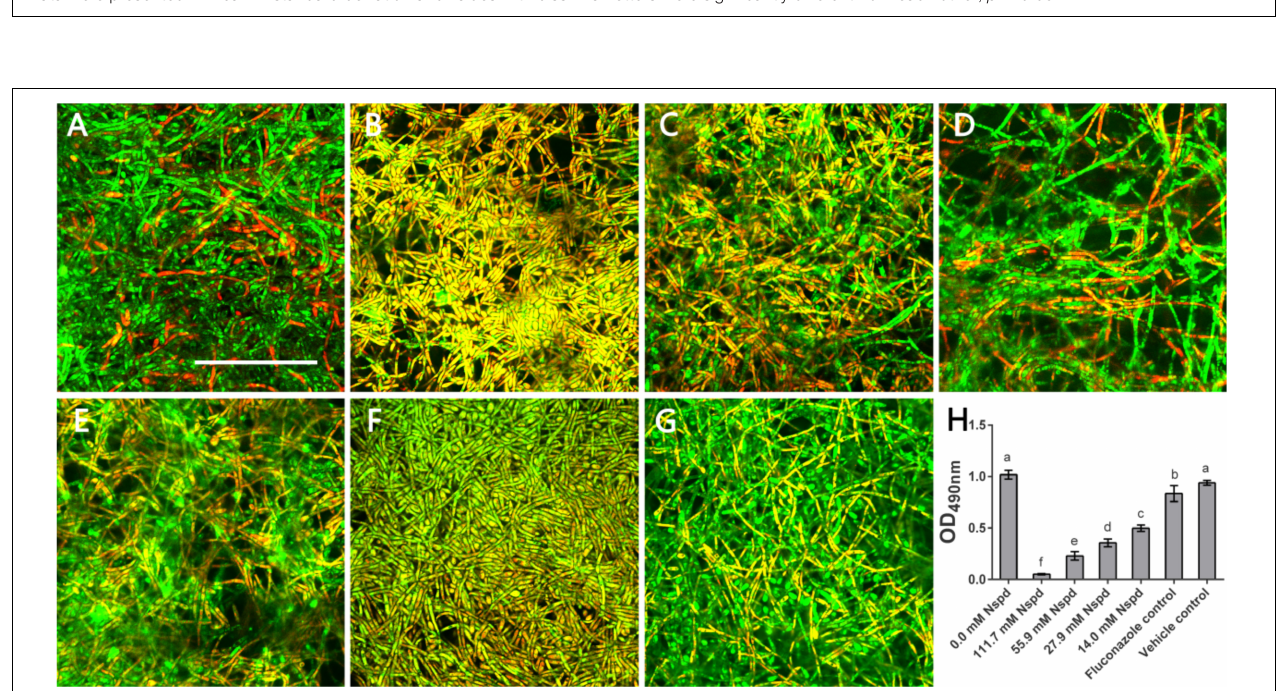
FIGURE 2 | Live/Dead staining and metabolic activity of C. albicans biofilms. Representative C. albicans biofilm images revealed by live/dead staining: (A) Blank control group (0 mM Nspd) showed few dead cells in a mature biofilm. (B–E) The number of dead cells (red) decreased as Nspd was diluted from 111.7 to 14.0 mM. (F) 80 µ M fluconazole group and (G) vehicle group (0.08% ethanol), both displayed a few dead cells inside the biofilm. Live cells appeared as green and dead cells appeared as red; yellow/orange colors were the result of an overlap of fluorescent dyes; bar = 50 µ m. (H) Metabolic activity of C. albicans biofilms was determined by XTT assay. A clear dosage effect relation was displayed in the metabolic level and dilution of Nspd. Nspd could significantly suppressed the metabolic activity of fungal cells in mature biofilm, much more effective than positive and vehicle controls. 14.0 mM Nspd could inhibit the metabolic activity level of mature fungal biofilm to half of the blank control’s (0.0 mM). Data were presented in mean ± standard deviation and values with dissimilar letters were significantly different from each other; p <